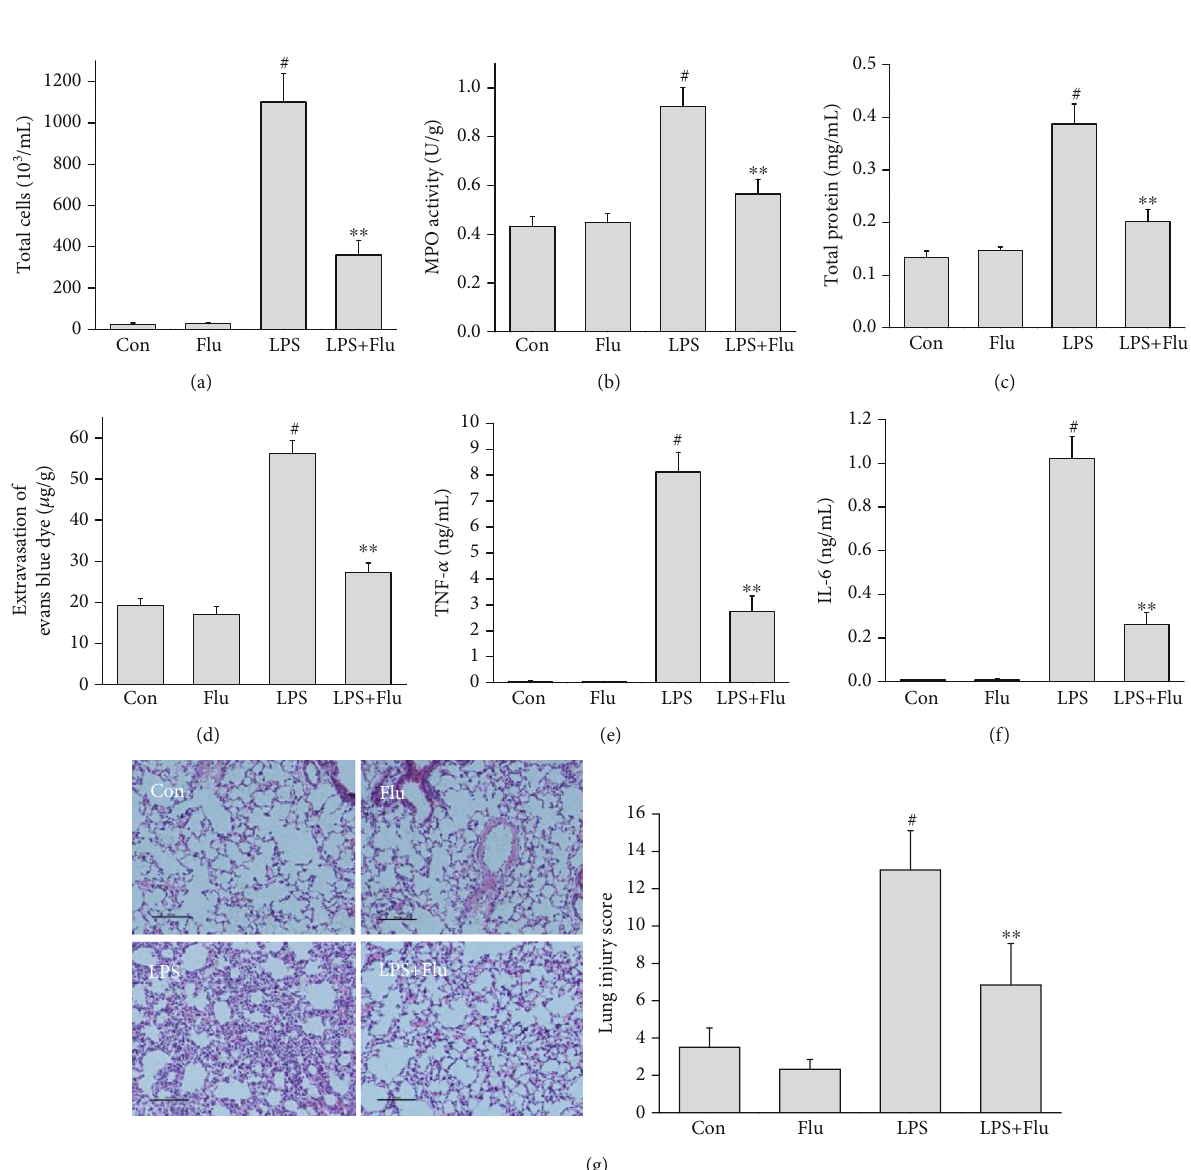
Figure 6: Preventive e ff ects of fl unarizine on LPS-induced ALI. Flunarizine (30 mg/kg) was treated 30 min before LPS exposure, and mice were sacri fi ced 6 h after LPS exposure. The total cell counts (a) in BALF, MPO activities (b) in lung tissue, total protein concentration (c) in BALF, extravasation of Evans blue dye (d) in lung tissue, TNF- α (e) and IL-6 (f) levels in BALF, and pathological changes (g) in the lung were measured. All values are mean ± SEM ( n = 6 ). # p < 0 : 05 , compared with vehicle-treated control; ∗ p < 0 : 05 , signi fi cant compared with LPS alone; ∗∗ p < 0 : 01 , signi fi cant compared with LPS